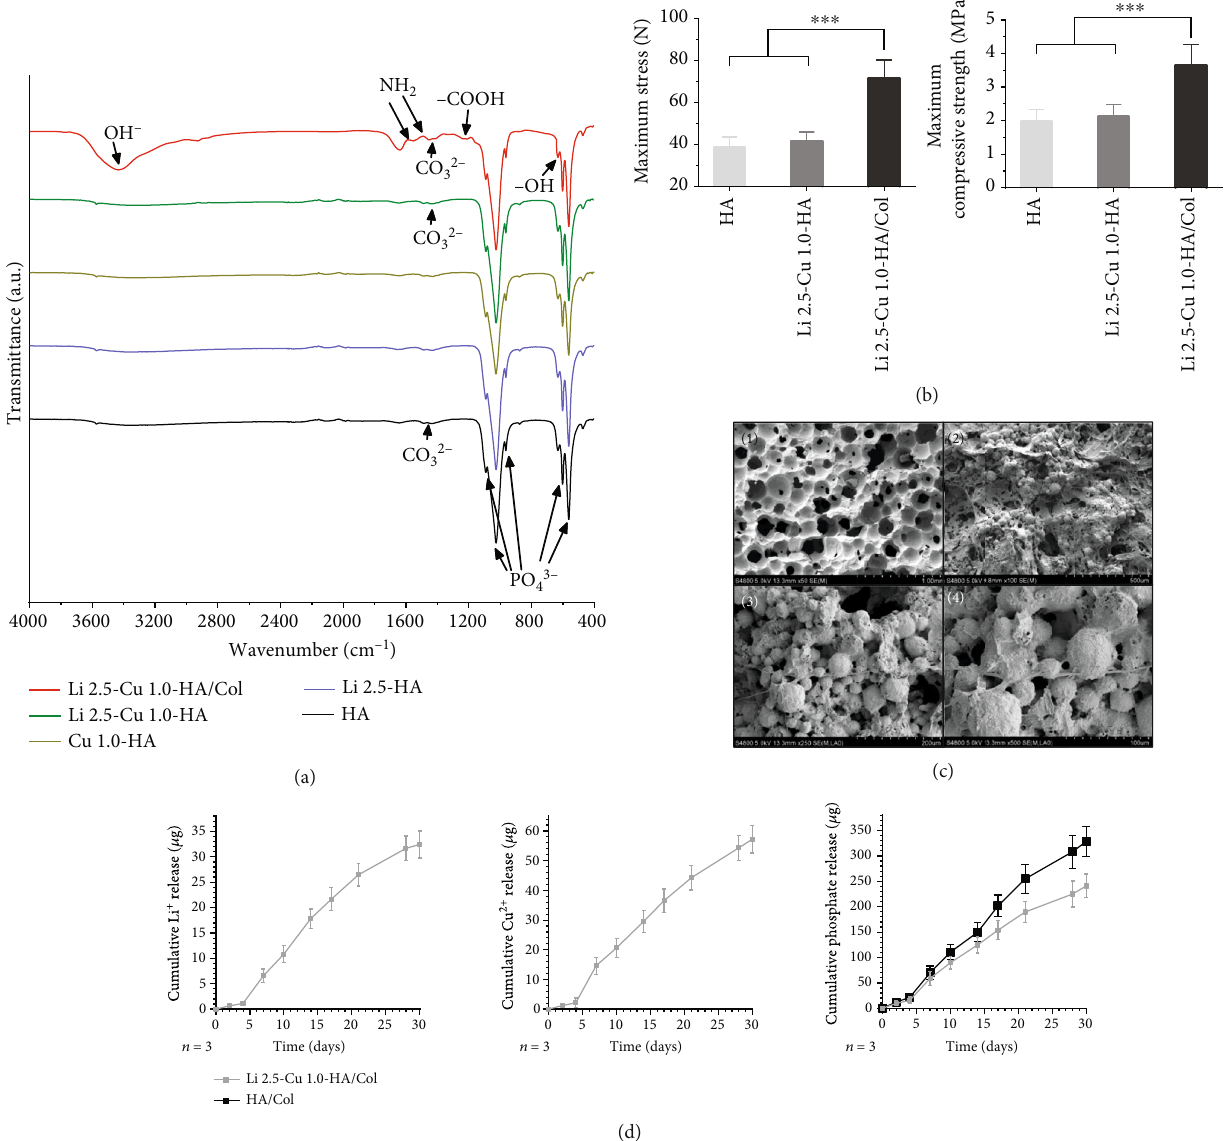
Figure 2: Li 2.5-Cu 1.0-HA/Col sca ff old has excellent physicochemical properties. (a) FTIR analysis results showed that the ceramic powder (HA, Li 2.5-HA, Cu 1.0-HA, and Li 2.5-Cu 1.0-HA) had the PO 43 − (1089, 1044, 962, 601, and 570 cm − 1 ) and OH - (3571 and 633cm − 1 ) absorption peak for hydroxyapatite and the NH (1680cm − 1 to 1630cm − 1 and 1570cm − 1 to 1510 cm − 1 ) and -COOH (1339cm − 1 ) 2 absorption peak for Li 2.5-Cu 1.0-HA/Col. (b) The comparison of maximum stress and maximum compression strength between Li 2.5- Cu 1.0-HA and Li 2.5-Cu 1.0-HA/Col. (c) SEM scan of Li 2.5-Cu 1.0-HA and Li 2.5-Cu 1.0-HA/Col sca ff olds. The Li 2.5-Cu 1.0-HA sca ff old had a porous structure with a pore size of 200-400 μ m (c, (1)). After vacuum infusion of type I collagen, the ceramic sca ff olds ’ surface was covered with collagen I fi bers and microspheres (c, (2) – (4)). (d) The Li + , Cu 2+ , and phosphate release curve of the Li 2.5-Cu 1.0-HA/Col sca ff old under simulated body fl uid (SBF)